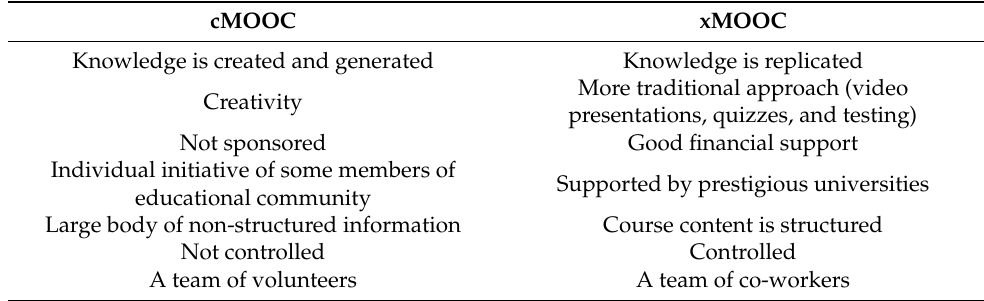
Table 1. cMOOC and xMOOC comparison [20] (p.